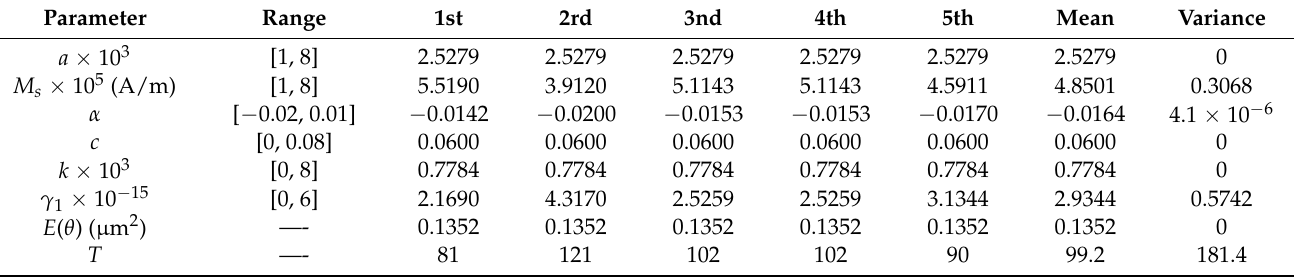
Table 3. Repeated identification results of the